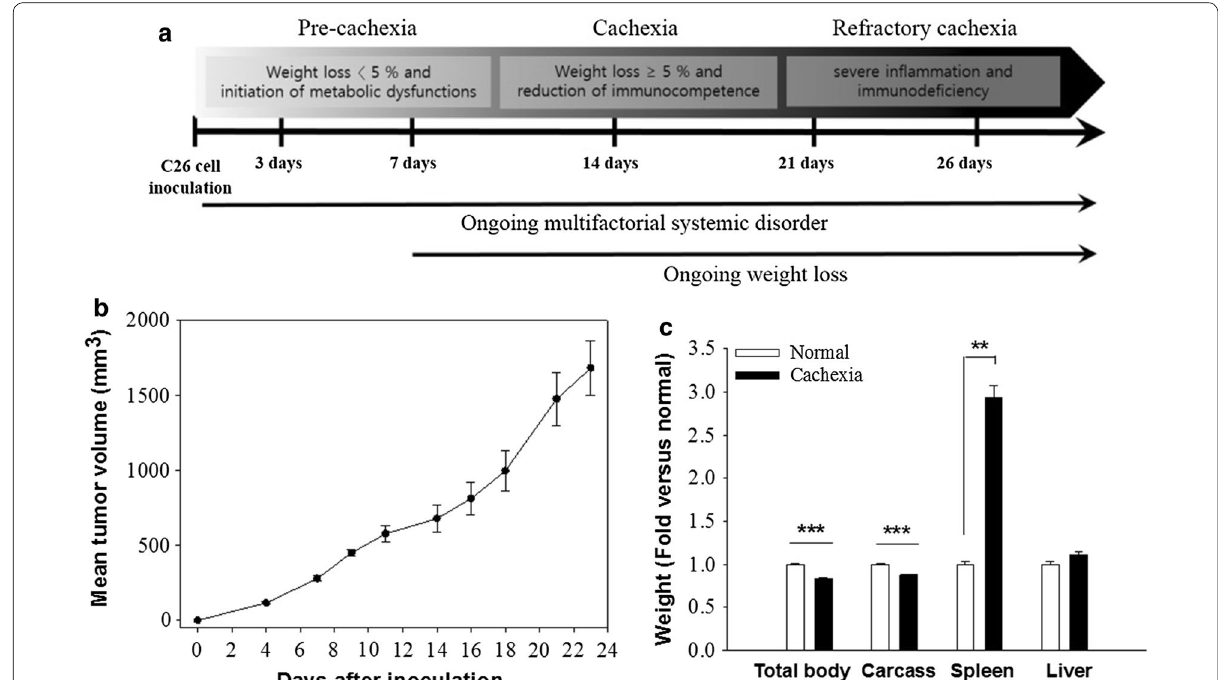
Fig. 1 Typical cachectic physiological changes in refractory cachexia. a Cachexia progression was determined by total body weight in C26 tumor‑bearing mice. The tumor volume was measured from 4 to 23 days after C26 cell inoculation. b Graph indicating the mean of tumor volume with SEM. c At 23 days after C26 cell inoculation, all mice were sacrificed; the total body, carcass, spleen, and liver were weighed. The bar graph represents the mean fold‑change in the cachexia group versus the normal group with SEM. ** P < 0.01 and *** P < 0.001 versus control. SEM, standard error of the